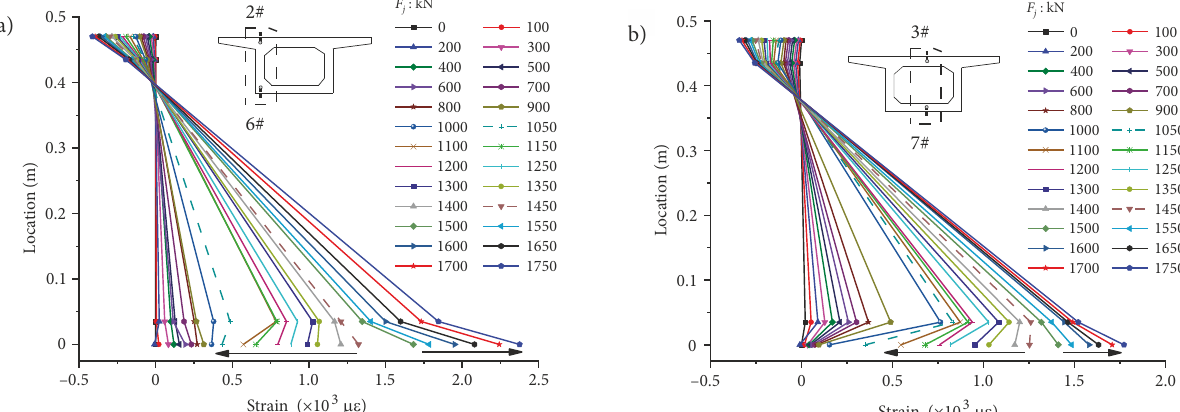
Figure 9. Location-strain curve of cross section B: (a) the changing feature of the web location’s stressing state; (b) the changing feature of the mid location’s stressing